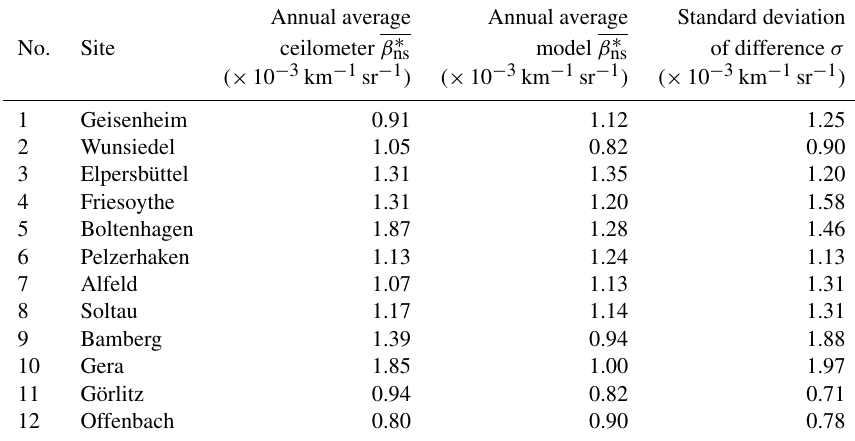
Figure 3. Time series (from 1 September 2015 to 31 August 2016) of the model simulation and ceilometer observation of near-surface attenuated backscatter β ∗ ns in km − 1 sr − 1 over Elpersbüttel with β ∗ ns being averaged from 200m (“full overlap height”) up to 1km above ground. Table 3. Summary of the annual mean β ∗ ns of both ceilometer measurements and model simulations from all 12 measurement sites. The standard deviation ( σ ) of the differences is also